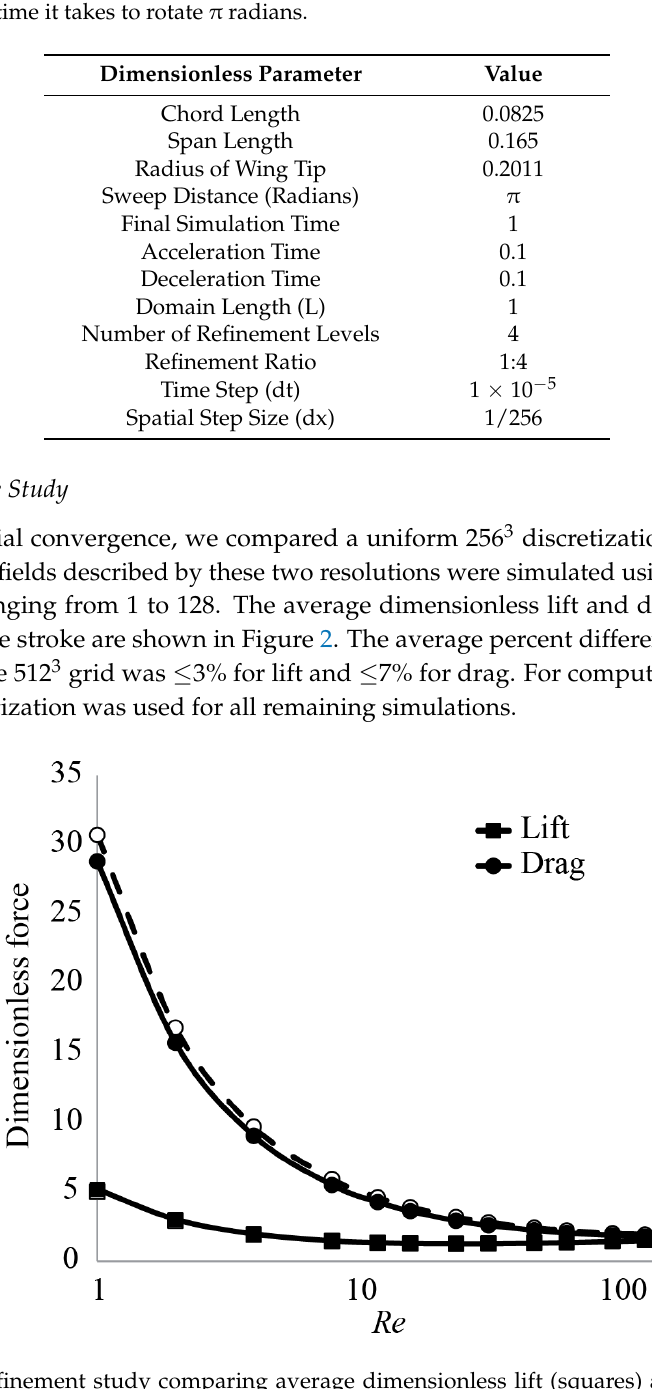
Figure 2. The refinement study comparing average dimensionless lift (squares) and drag (circles) over a range of Re at 256 3 (open markers) and 512 3 (solid markers) grid discretization. The average dimensionless force was calculated over the steady part of the stroke. Effective 256 3 grid discretization was used for all other simulations in this study.